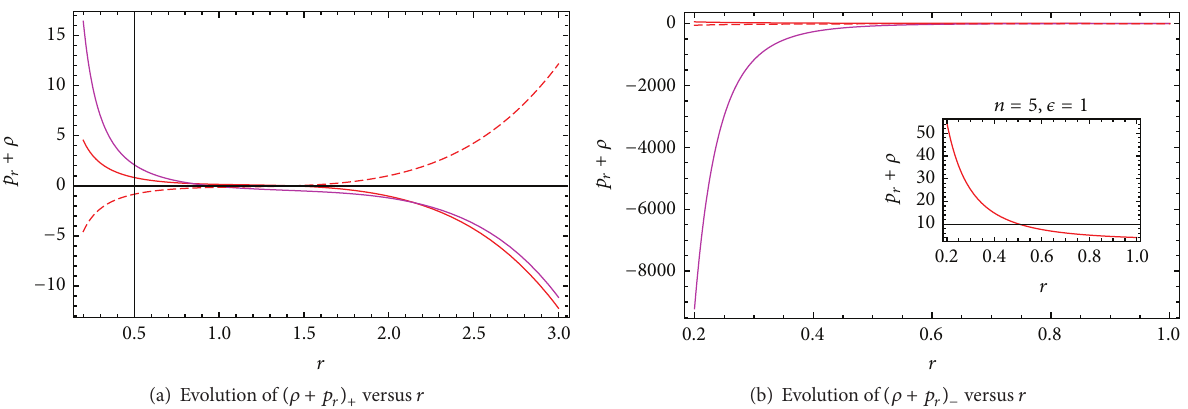
Figure 7: Plots of (a) 𝜌 + 𝑝 𝑟 for 𝑠 + and (b) 𝜌 + 𝑝 𝑟 for 𝑠 − versus 𝑟 in Lorentzian distribution for 𝑛 = 5 , 𝜖 = 1 (red), 𝑛 = 5 , 𝜖 = −1 (red dashed), and 𝑛 = 6 , 𝜖 = 3